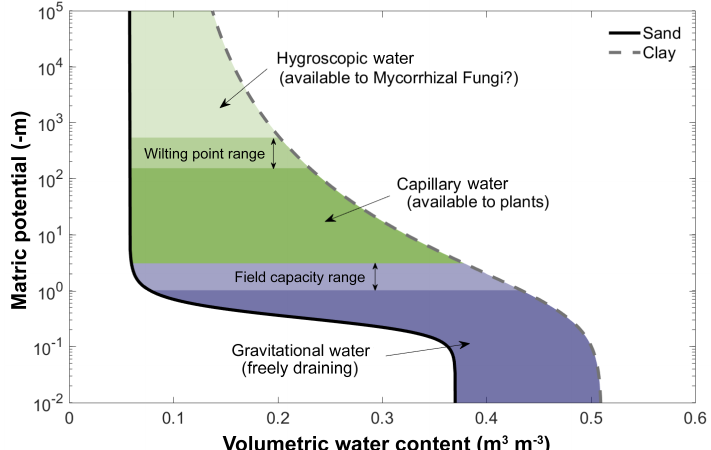
Figure 4. Water available to streams, trees, and mycorrhizae may come from pores that drain under different tensions. Only water that is freely draining will contribute to streamflow, whereas matrix waters, held at tension in soils or rock, will not. Matrix waters include capillary waters available to plants, and hygroscopic waters that are held at tensions beyond the wilting point (and thus unavailable to) agronomic plants. Such waters may be available to mycorrhizal fungi (see hypothesis 8). More energy is required to acquire water that is held under higher tensions, so we hypothesize that plants will use water that is most energetically favorable (hypothesis